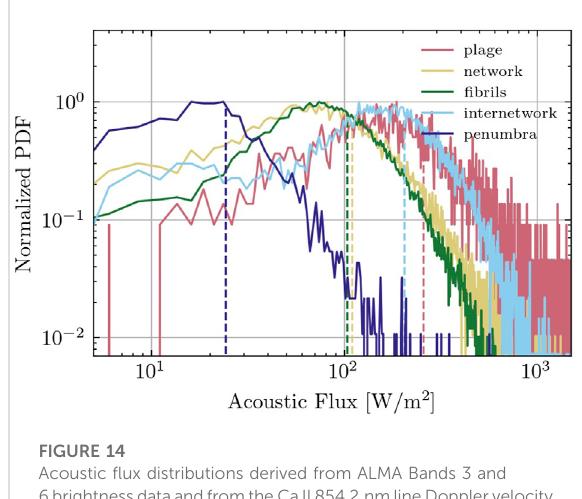
FIGURE 14 Acoustic fl ux distributions derived from ALMA Bands 3 and 6brightnessdataandfromtheCaII854.2 nmlineDopplervelocity data based on the RADYN models. The vertical lines mark the medians of the distributions. From Molnar et al. (2021). Reproduced by permission of the